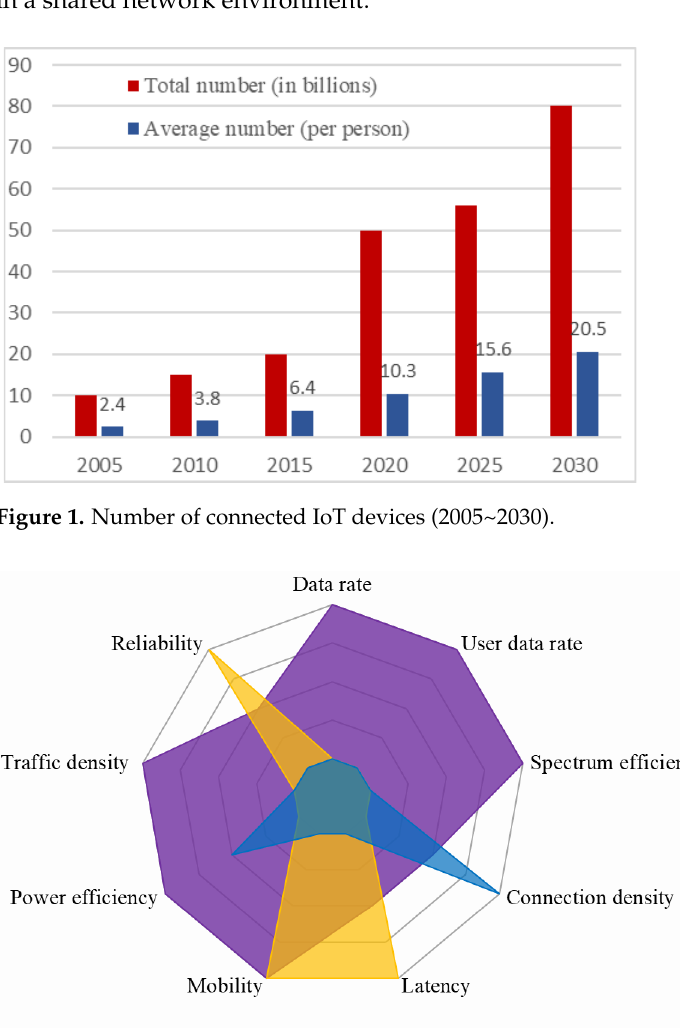
Figure 1. Number of connected IoT devices (2005~2030).